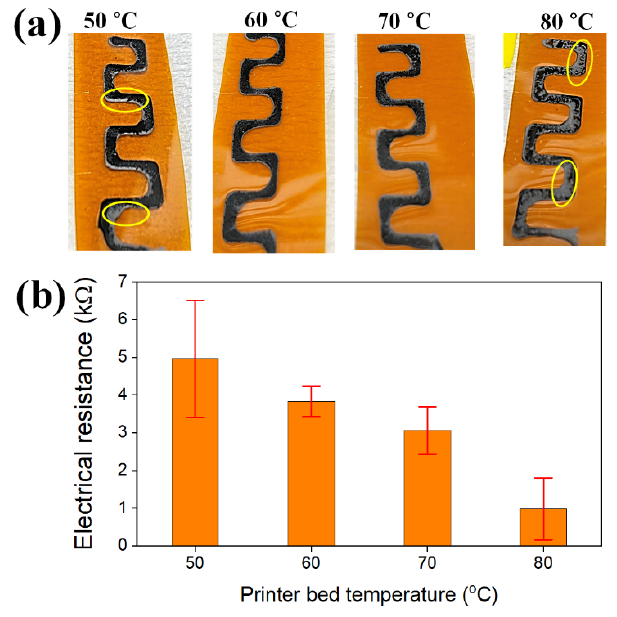
Figure 8. ( a ) Photo images of EEG/PEDOT:PSS composite electrodes on the polyimide substrate according to the bed temperature of the 3D printer. Yellow circles denote the agglomeration of EEG sheets. ( b ) Changes to the electrical resistances and standard deviations of the EEG/PEDOT:PSS composite electrodes.